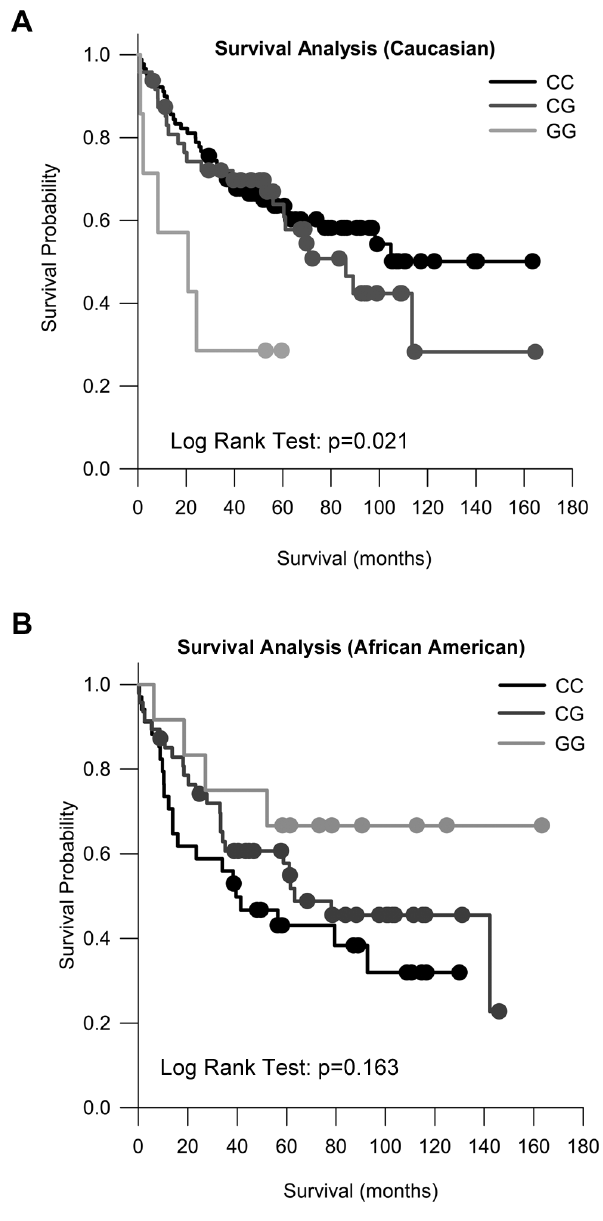
Figure 1. Rs4919510 and colorectal cancer survival stratified by race. Kaplan Meier survival curves depicting the relationship between rs4919510 and colorectal cancer survival in A) Caucasians (n=145) and B) African Americans (n=94). Censored individuals are indicated with a closed circle. doi:10.1371/journal.pone.0036306.g001 in Caucasians. Proportional hazards assumptions were verified by visual inspection of log-log plots and using a non-zero slope test of the Schoenfeld residuals [21] (p= 0.91 for African Americans, p = 0.79 for Caucasians). The method of Kaplan and Meier was used for plotting genotypes and survival, where death due to colorectal cancer was again considered as the endpoint. These graphs were generated using SigmaPlot 12.0 (Systat Software, San Jose, CA). Significance was tested using the Log-Rank method.